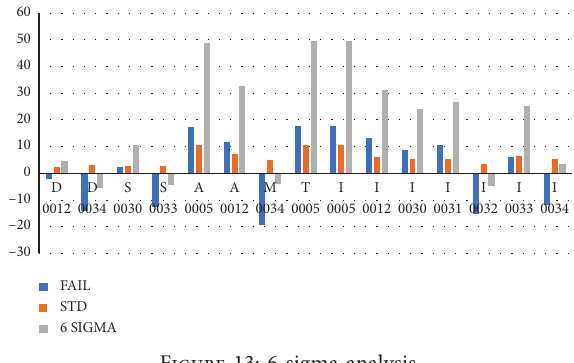
Figure 13: 6 sigma